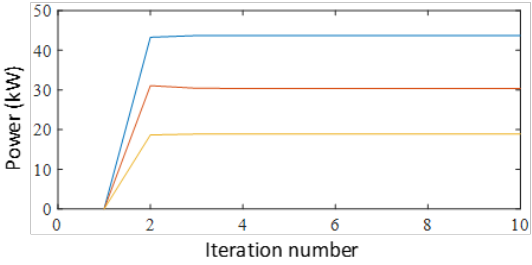
Figure 11. Results for optimal power allocation (case 2). Table 5. Initial shortage in microgrids and optimal power allocation for case2.